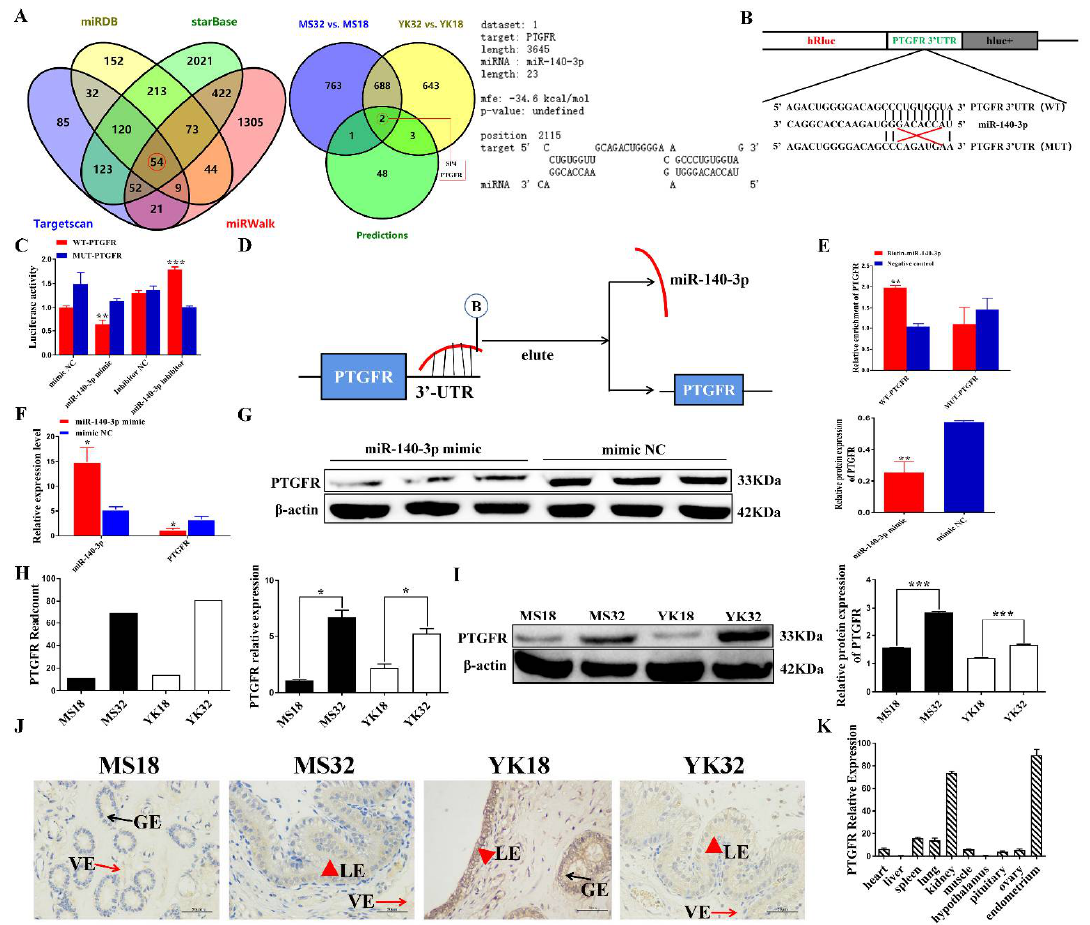
Figure 5. PTGFR acts as the functional target gene of miR-140-3p in EECs. ( A ) Venn plot showed the potential mRNAs of miR-140-3p according to multiple bioinformatics tools and RNA-seq data. ( B ) PTGFR protein functioned as the downstream target of miR-140-3p with complementary binding sites at the 3′ UTR. ( C ) Luciferase reporter assay validated the relative fluorescence intensity after the PTGFR 3′ UTR wild-type or mutant was co-transfected with miR-140-3p mimic or mimic NC and miR-140-3p inhibitor or inhibitor NC. ( D ) Schematic diagram displaying the pull-down of PTGFR caused by a biotin-labeled miR-140-3p probe. ( E ) RNA pulldown assay was performed with biotin-miR-140-3p, control or WT-PTGFR, or MUT-PTGFR using EECs extracts. The levels of miR-140-3p in immunoprecipitates were detected by qRT-PCR. ( F ) Overexpression of miR-140-3p down-regulated the PTGFR mRNA level in EECs. ( G ) Western blot showed the effect of overexpression of miR-140-3p on PTGFR protein expression. ( H ) The PTGFR mRNA levels in Yorkshire and Meishan endometrium at 18 and 32 days of pregnancy. ( I ) The protein levels of PTGFR in Yorkshire and Meishan endometrium at 18 and 32 days of pregnancy were detected by Western blot. ( J ) Immunohistochemical staining for PTGFR protein in endometrial tissue of Yorkshire and Meishan at 18 and 32 days of pregnancy. LE, luminal epithelium; GE, glandular epithelium; VE, vascular epithelium. ( K ) Detection of PTGFR expression level in 32-day pregnancy tissues Yorkshire pig by qRT-PCR. Error bars represent mean (n = 3) ± SD Student’s t -test; * p < 0.05, ** p < 0.01, *** p < 0.001.